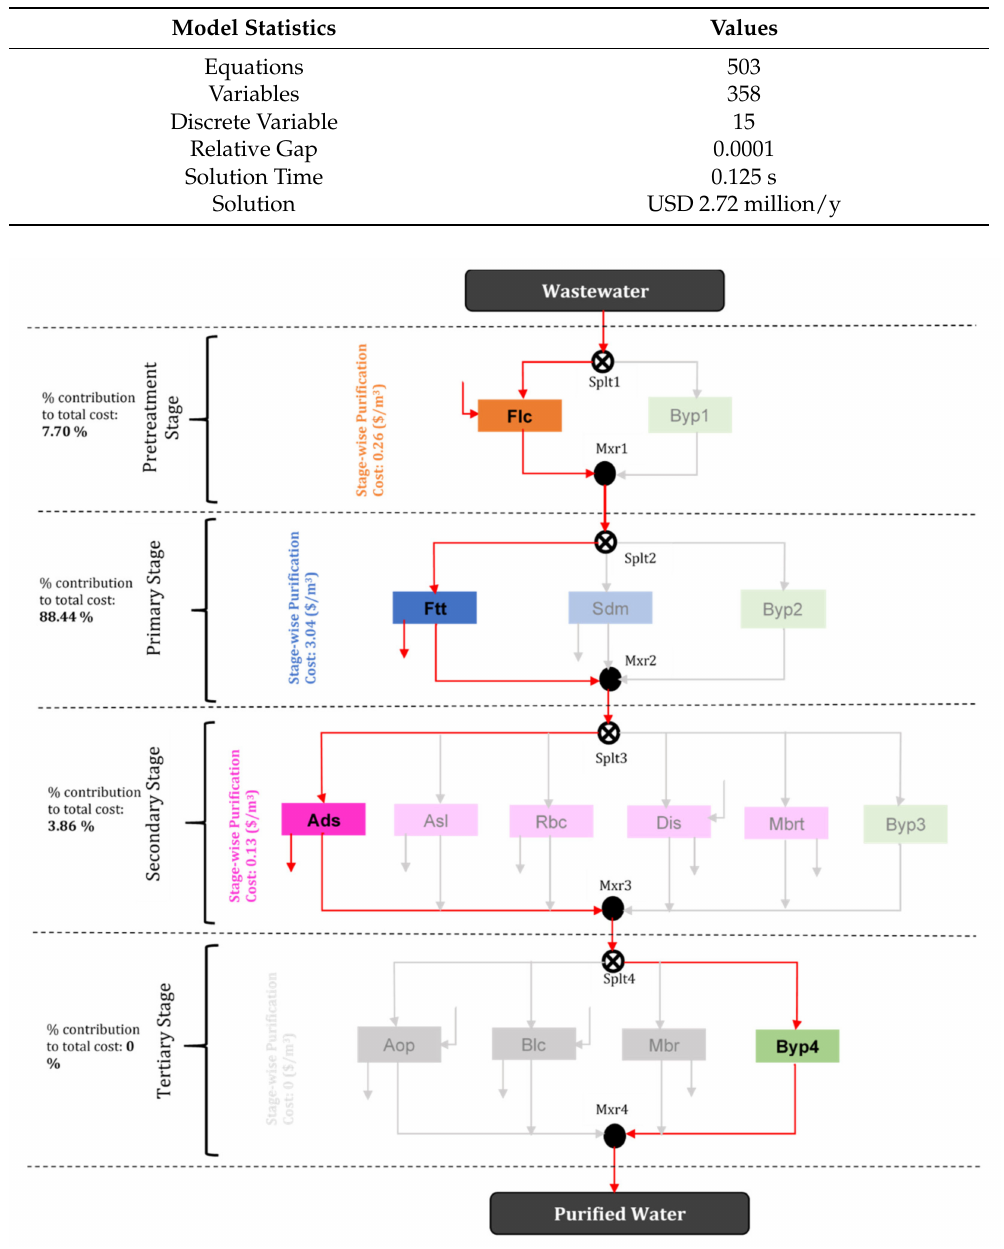
Table 7. GAMS summary statistics for pharmaceutical WWT case study.